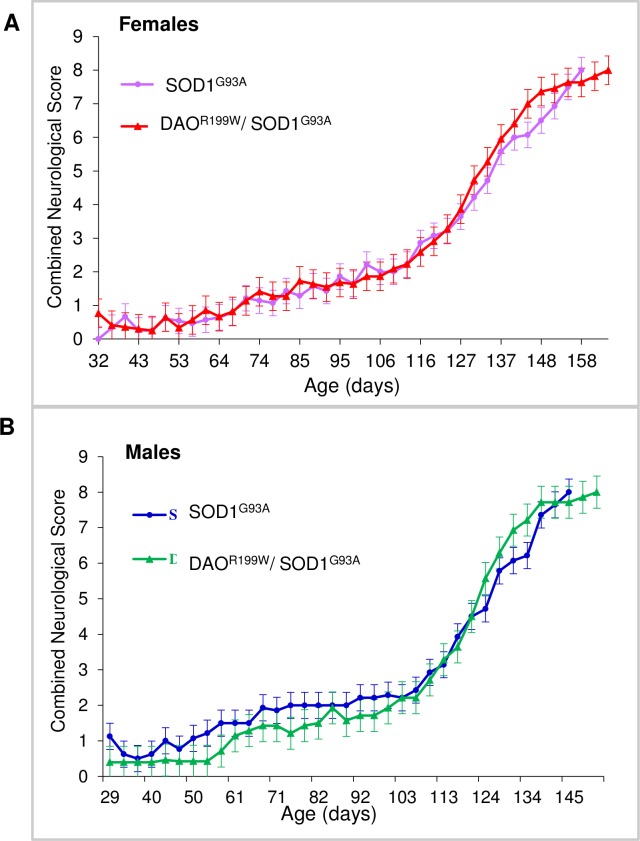
Longitudinal assessment of neurological scores in female SOD1G93A and double transgenic (SOD1G93A/DAOR199W) littermates (A) and for male mice (B). Mean group combined neurological score plotted for SOD1G93A and double transgenic (SOD1G93A/DAOR199W) mice over time from approximately 30 days of age until all the animals within a group died and the study was terminated (n ≥ 14 per experimental group). A combined neurological score was calculated for each mouse at each time point through summation of the neurological scores recorded for its left and right hind-limbs. Values are means with standard error of the mean (SEM) indicated by error bars. (A) SOD1G93A females are presented in purple, and the double transgenic (SOD1G93A/DAOR199W) littermates are displayed in red. (B) SOD1G93A males are presented in blue, and the double transgenic (SOD1G93A/DAOR199W) littermates are displayed in green.